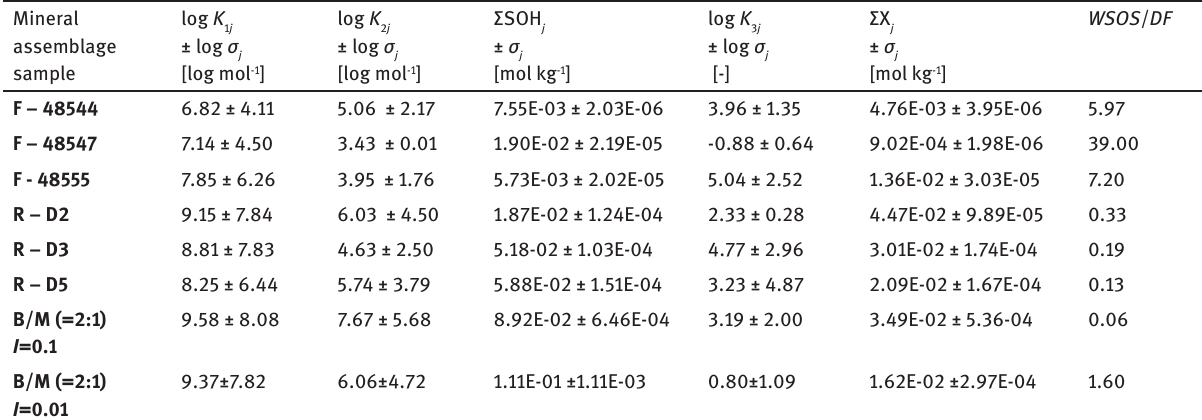
Table 4: Titration curve overall parameters of MA samples F, R and B/M obtained by GC-approach code used to the evaluation of the (( Q ) ) = f[ H + ] data, i.e., of the CA-approach results. (CEM + IExM models were applied; the values of equilibrium constants were cal tota l i i extrapolated to I = 0 by means of Davies